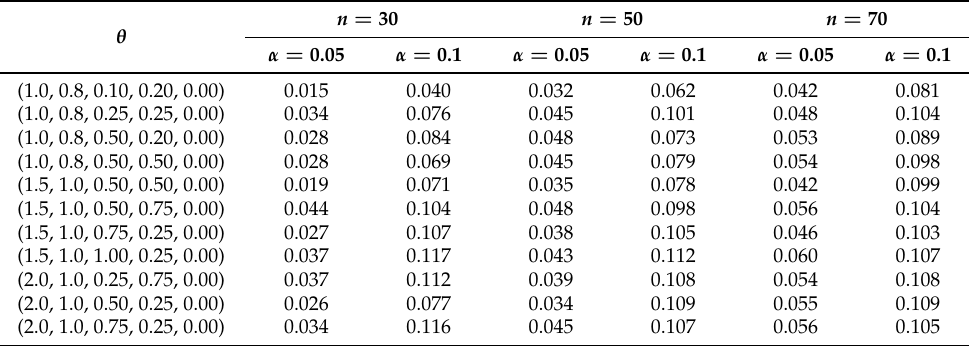
Table 6. Simulation results for the probability of type I error for a 1 = 5 and a 2 = 1.